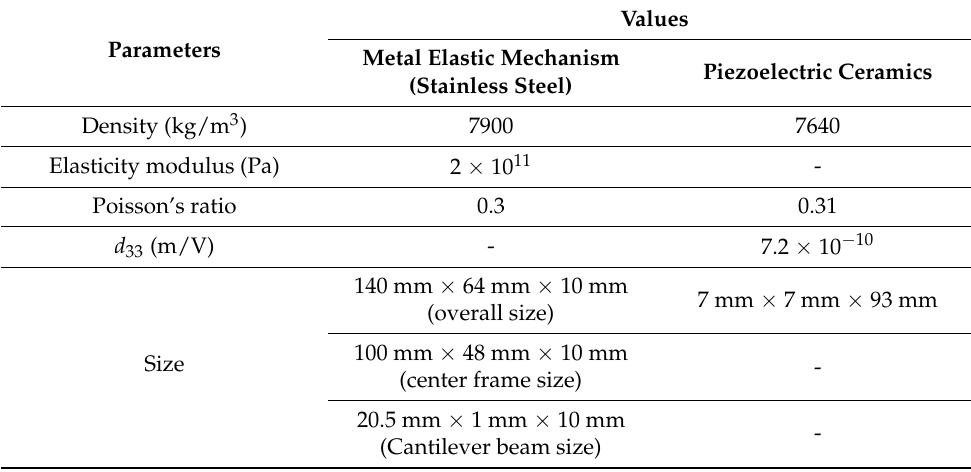
Figure 9. The first three modes of the structure. Table 1 with the main materials and dimensions of the piezoelectric mechanism is attached. Table 1. Main materials and dimensions of the piezoelectric mechanism.